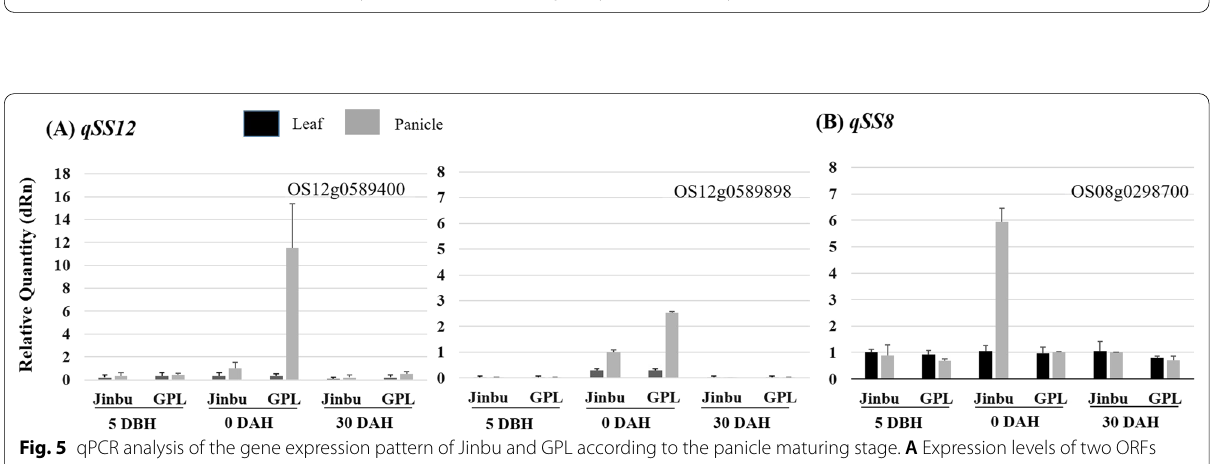
Fig. 4 Fine mapping of the target regions of qSS12 ( A ) and qSS8 ( B ) on chromosomes 12 and 8, respectively. The black and white bars indicate homozygous alleles derived from Jinbu and GPL, respectively, and the gray bars show heterozygous alleles. The number in brackets indicates the number of recombinant events detected by discordance between genotype and phenotype